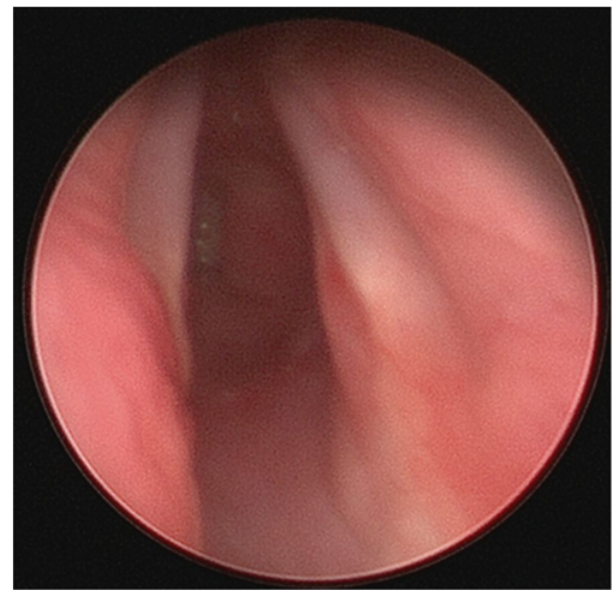
Figure 3. Severe subglottic stenosis.